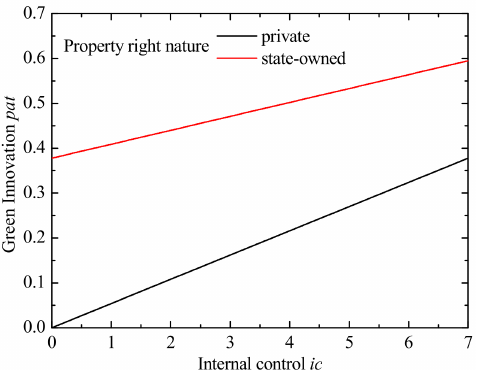
Figure 2. Regulatory effect of property right nature. Table 7. Heterogeneity test of property right nature and enterprise